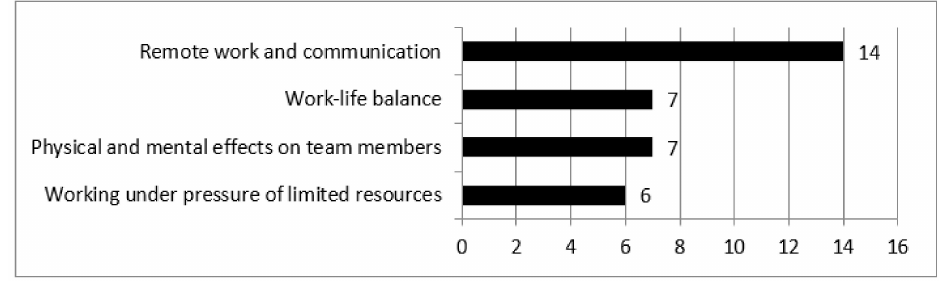
Figure 3. Impact of the COVID-19 pandemic on the organization of work of project